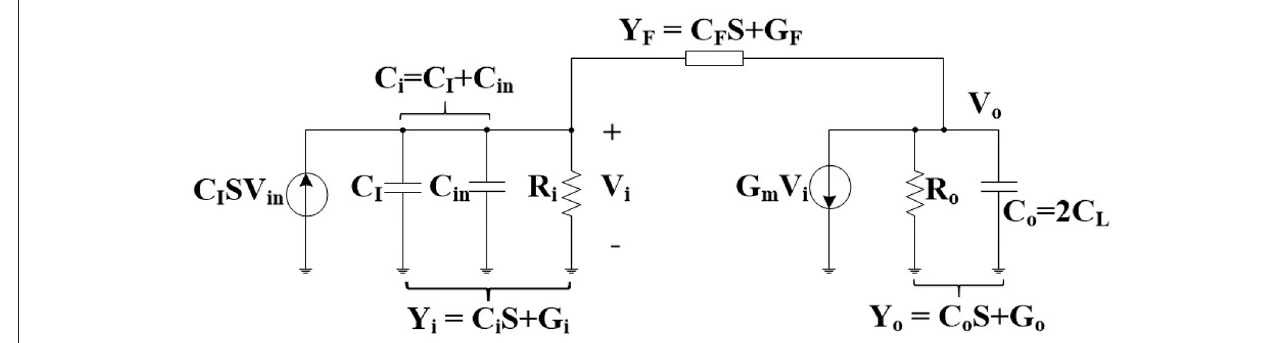
FIGURE 3 | Small signal equivalent of the half-circuit of the neural amplifier.